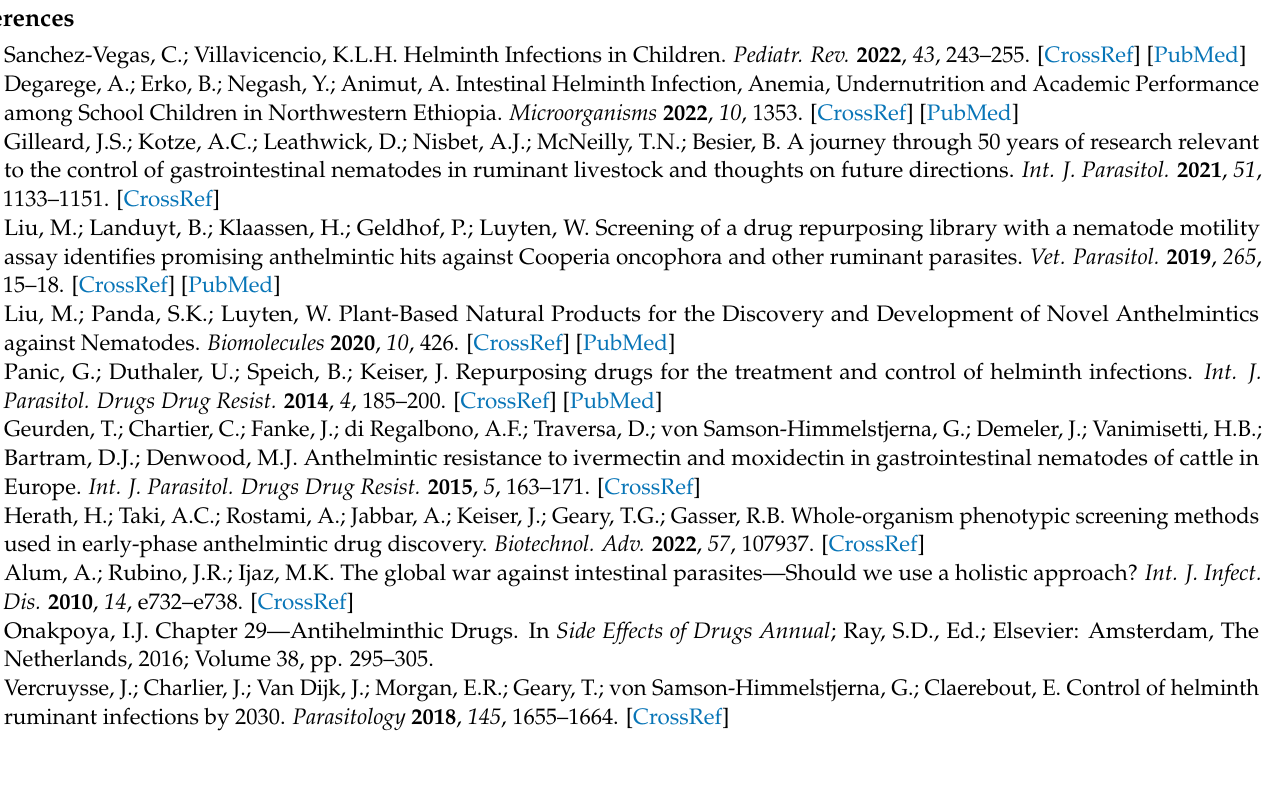
Figure S2: 13 C-NMR spectrum of the active peak; Figure S3: HRMS spectra of